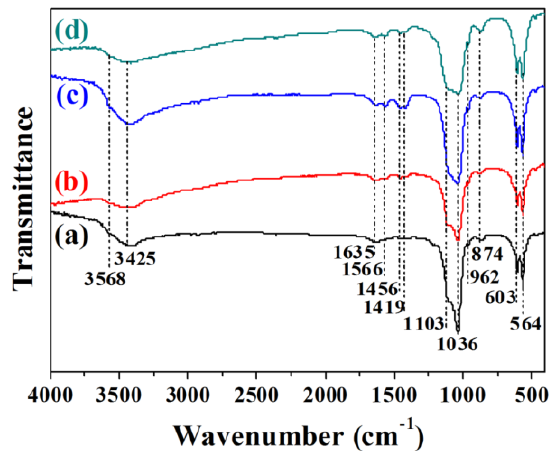
Figure 3. FTIR spectra of calcium phosphate nanostructures prepared by microwave-assisted hydrothermal method under different pH values: ( a ) Sample A, pH = 5; ( b ) Sample B, pH = 7; ( c ) Sample C, pH = 9; ( d ) Sample D, pH =